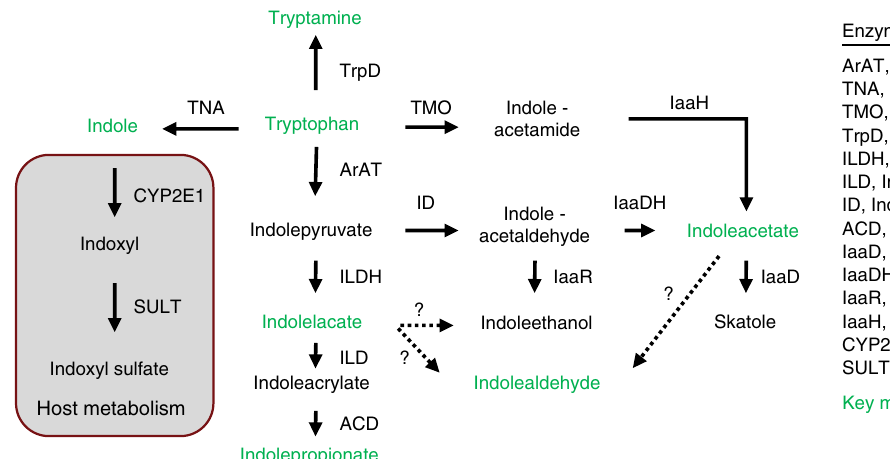
Fig. 2 Microbial generation of tryptophan catabolites in the human gut. Overview of the different ways microbes degrade tryptophan in the human gut. The metabolites that are most often found in the human gut are colored in green. Dashed lines represent pathways where no enzymes have been identi